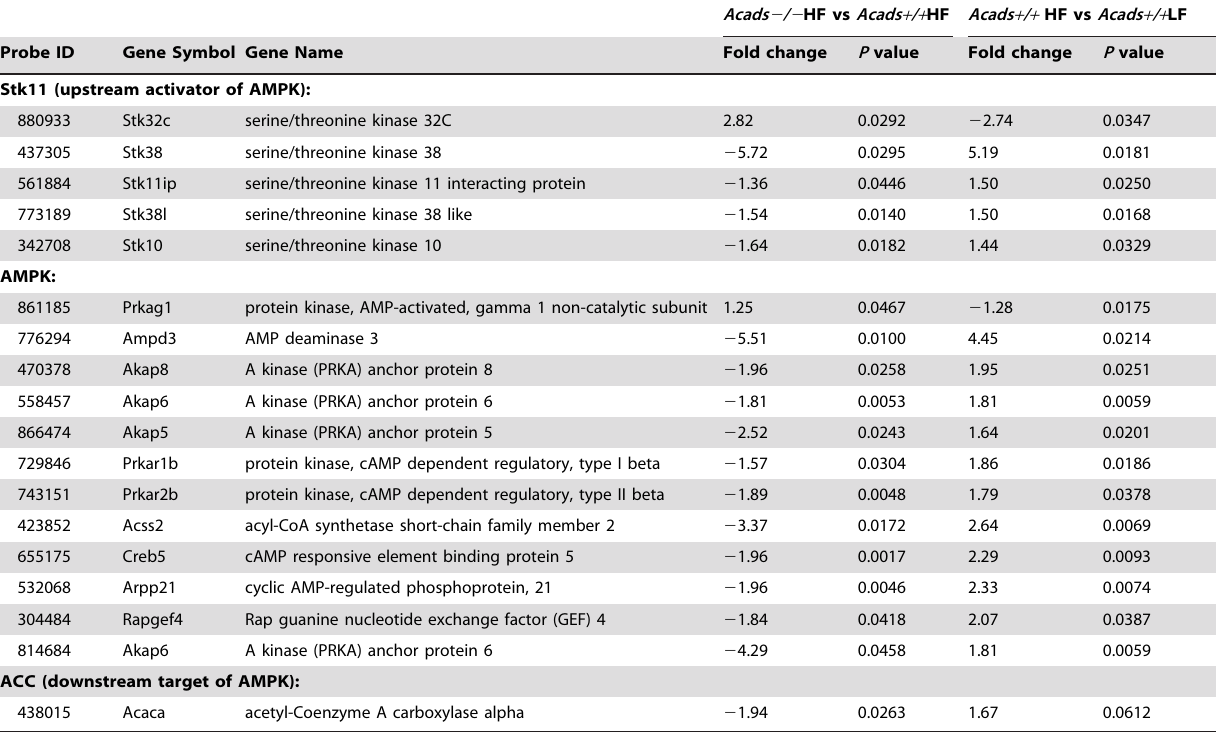
Table 2. Differentially expressed AMP-kinase related genes in microarray of